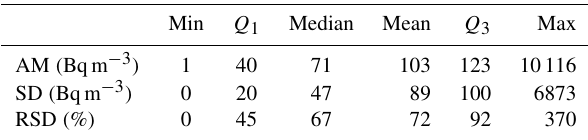
Table 2. Summary statistics of indoor radon data (AM_z) after merged border grids ( N =